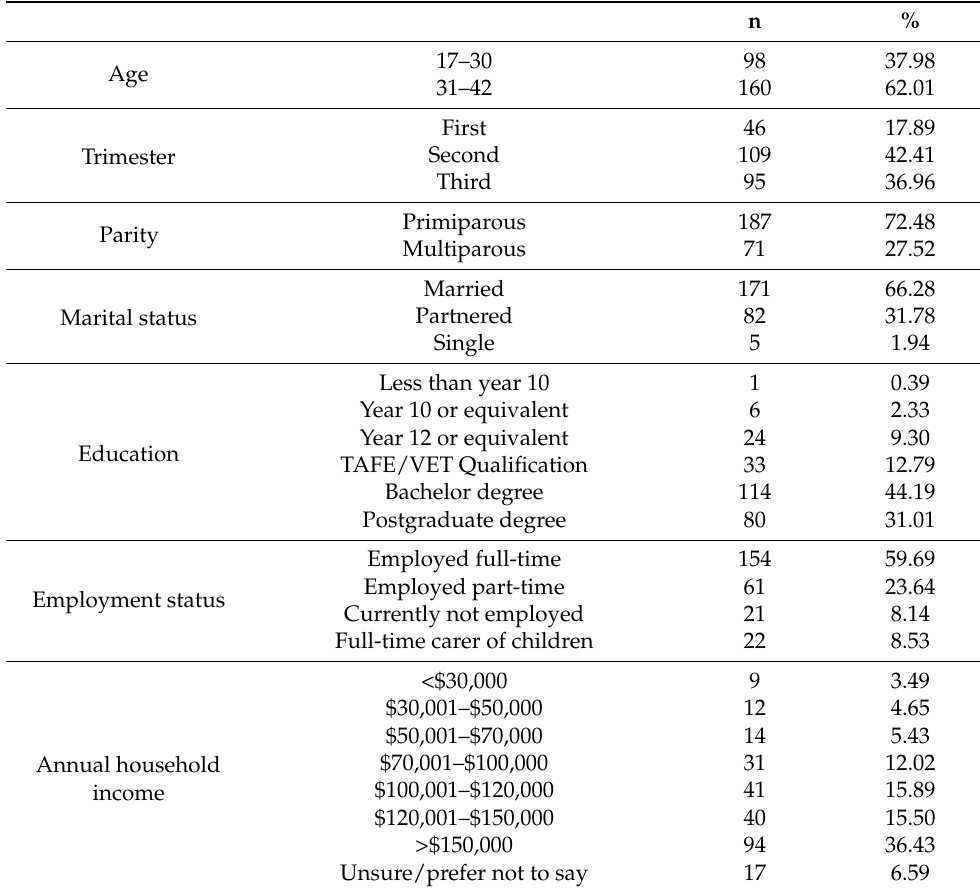
Data listed in Table 1 represent participants within the